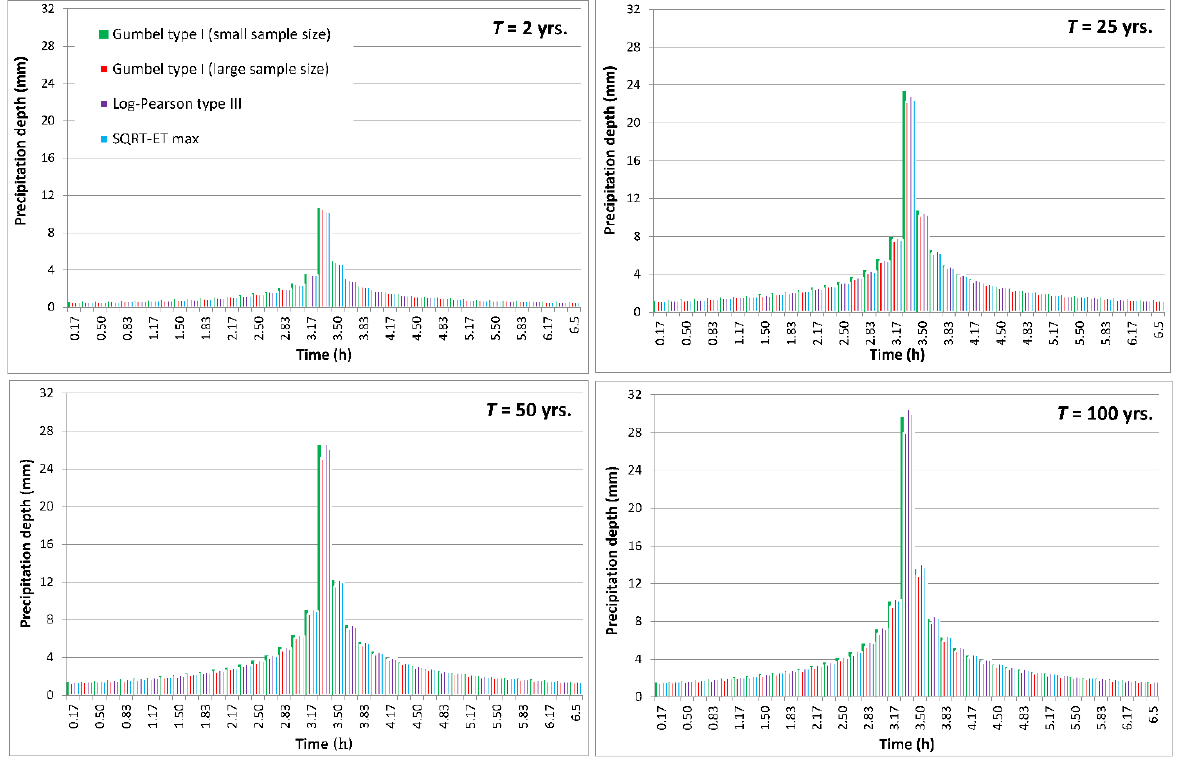
Figure 11. Design hyetographs for T = 2, 25, 50 and 100 years. The blocks that correspond to GBS are highlighted in green.